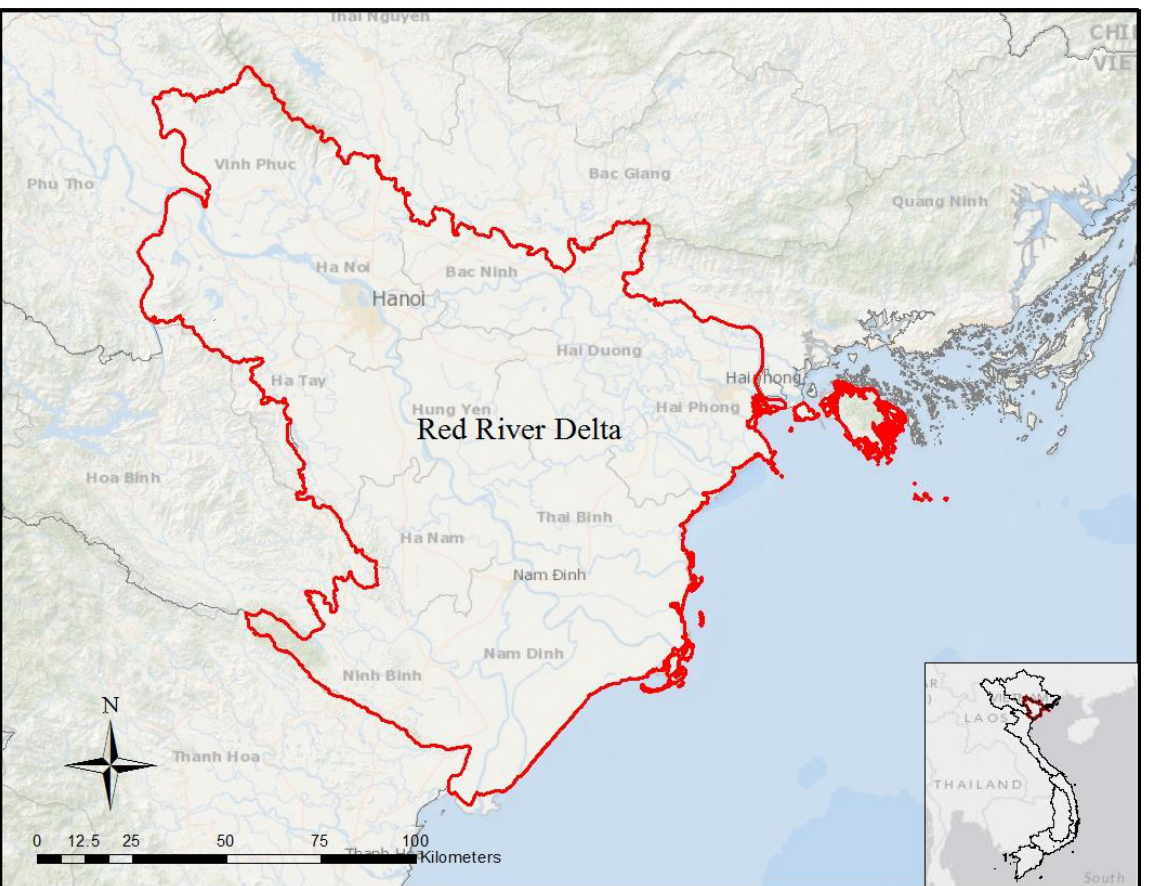
Figure 1. The study area—The Red River Delta of